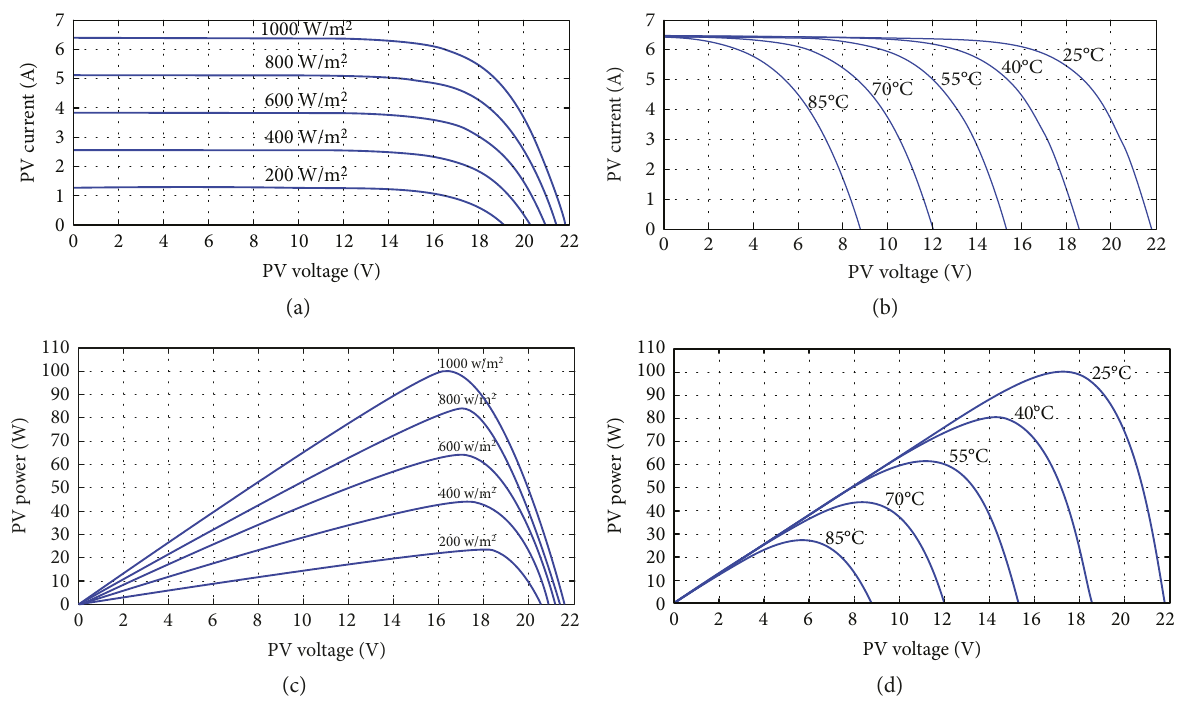
Figure 3: (a) Theatrical I - V characteristics with radiation at constant temp. (25 ° C). (b) P - V characteristics with radiation at constant temp. (25 ° C). (c) I - V characteristics with temperature at constant radiation (1000W/m 2 ). (d) P - V characteristics with temperature at constant radiation (1000W/m 2 ).